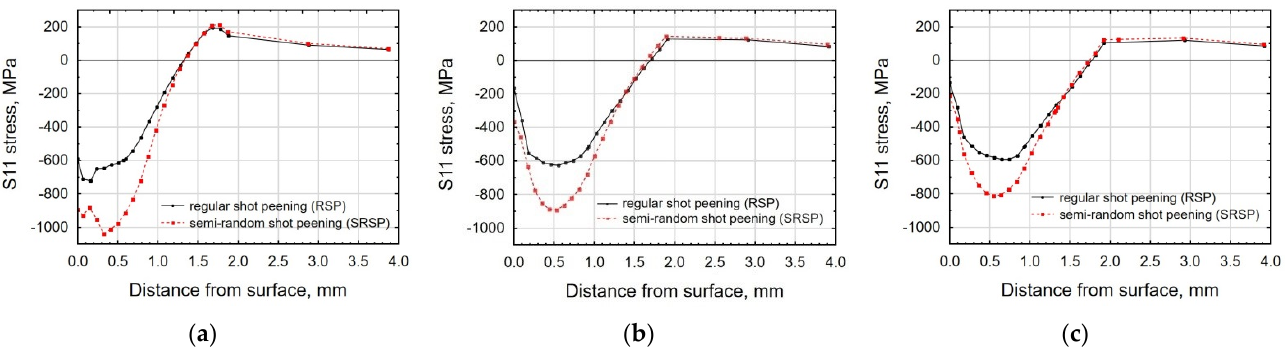
Figure 18. Comparison of the S11 stress distribution for RSP and SRSP as a function of distance from the surface for different ball diameters: ( a ) D = 3 mm, ( b ) D = 10 mm, ( c ) D = 15 mm.